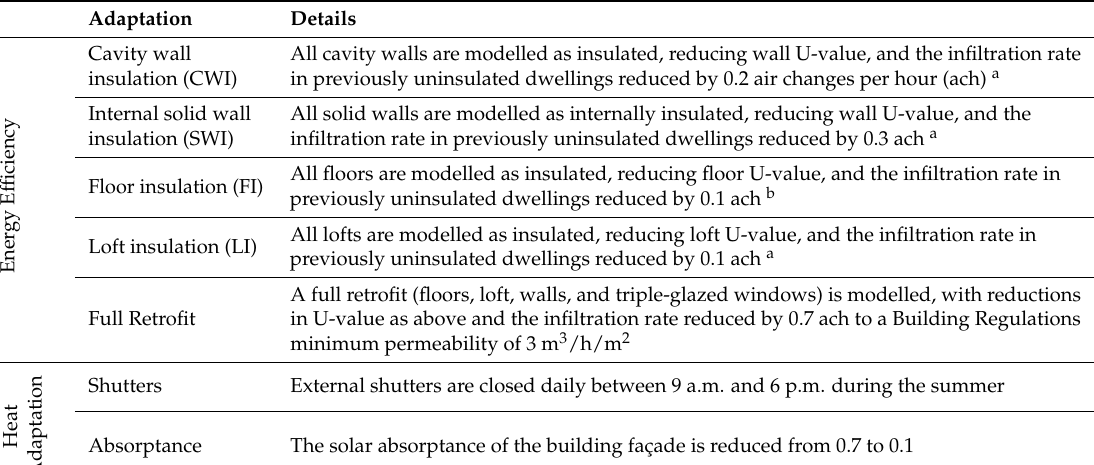
Table 1. The adaptations and underlying assumptions modelled. The reduction in fabric U-value is based on the UK Government’s Standard Assessment Procedure (SAP) for Energy Rating of Dwellings, with the lowest possible U-value for the fabric component selected based on the fabric type and dwelling age [35]. The change in permeability is estimated based on the work by a Hong et al. [36] or b UK SAP, following the methods described by Hamilton et al.